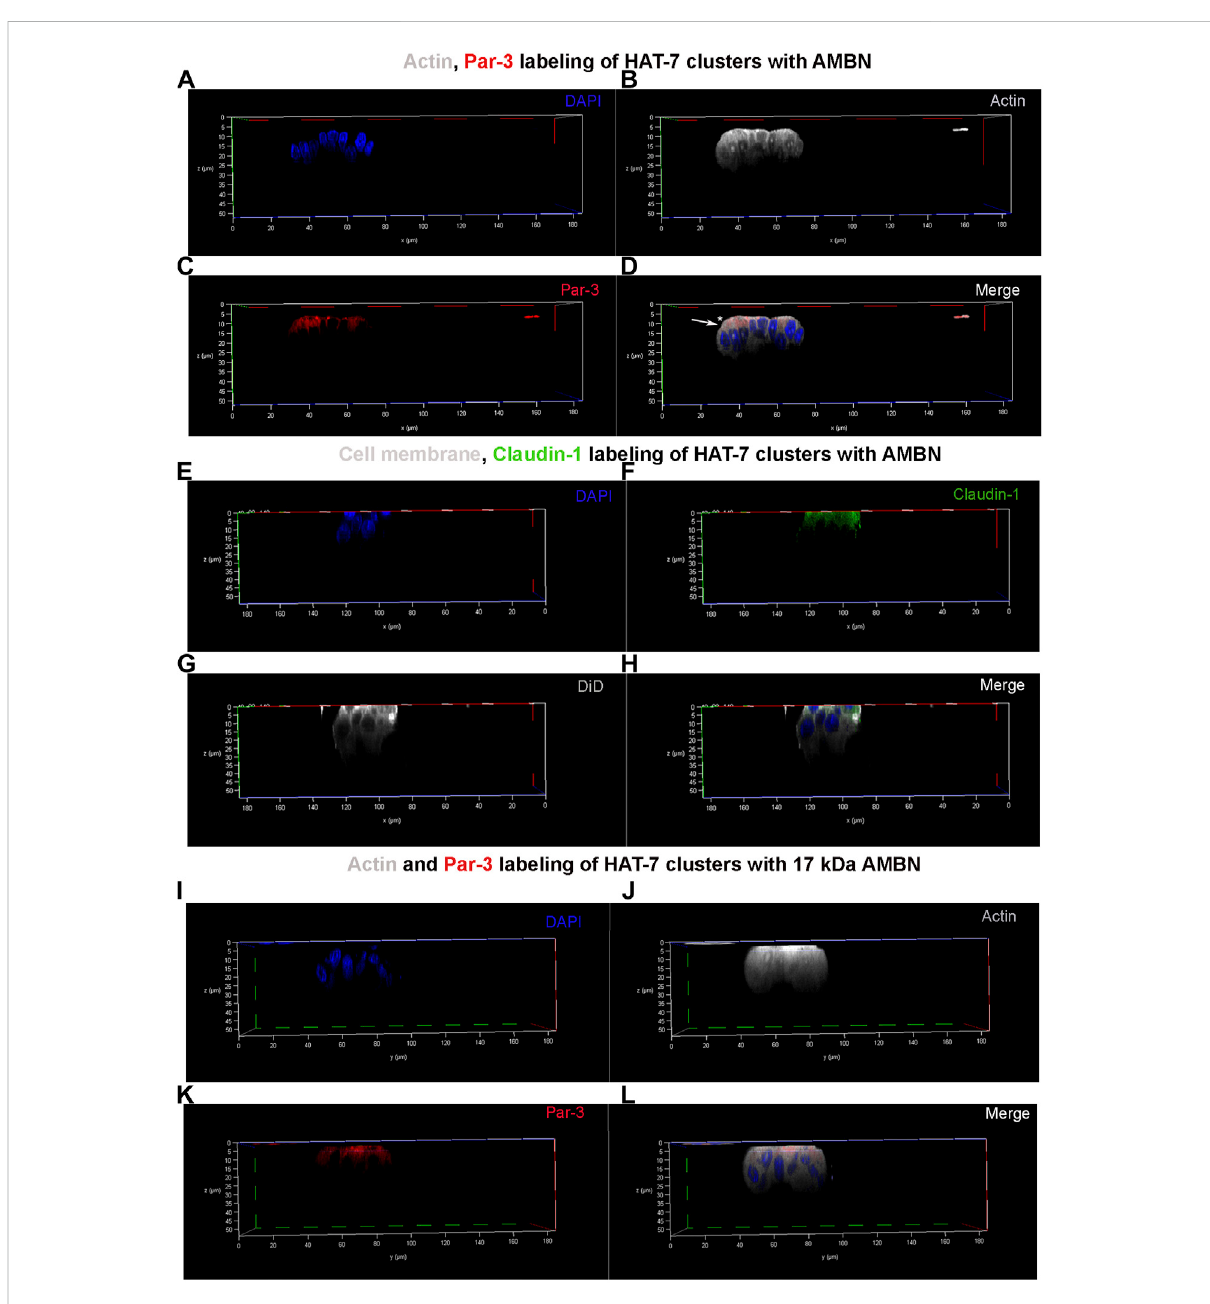
FIGURE 4 Par-3andClaudin-1polarizationinHAT-7clustersina3Daxialview. (A – C) Individualchannelsfornucleus(DAPI),actin(greypseudocolor)and Par-3 (red) distribution respectively in HAT-7 cells cultured with AMBN. (D) Merged image of all three channels revealing a uniform symmetrical labelingofactinwithanasymmetricalandpolarizeddistributionofPar-3(whitearrow). (E – G) Individualchannelsfornucleus(blue),claudin-1(green) and DiD (grey pseudo color) respectively in HAT-7 cells cultured with ameloblastin. (H) Merged images of all three channels revealing selective claudin-1 labeling within the pole of the cells basal to nucleus. DiD labeling is uniform throughout the entire outline of the cells. (I – K) Individual channels for nucleus (DAPI), actin (grey pseudo color) and Par-3 (red) distribution in HAT-7 cells cultured with AMBN 17 kDa cleavage fragment respectively. (L) Mergedimageofallthreechannels revealingauniformsymmetricallabelingofactinwithanasymmetricalandpolarizeddistribution of Par-3 like the observations in (D)